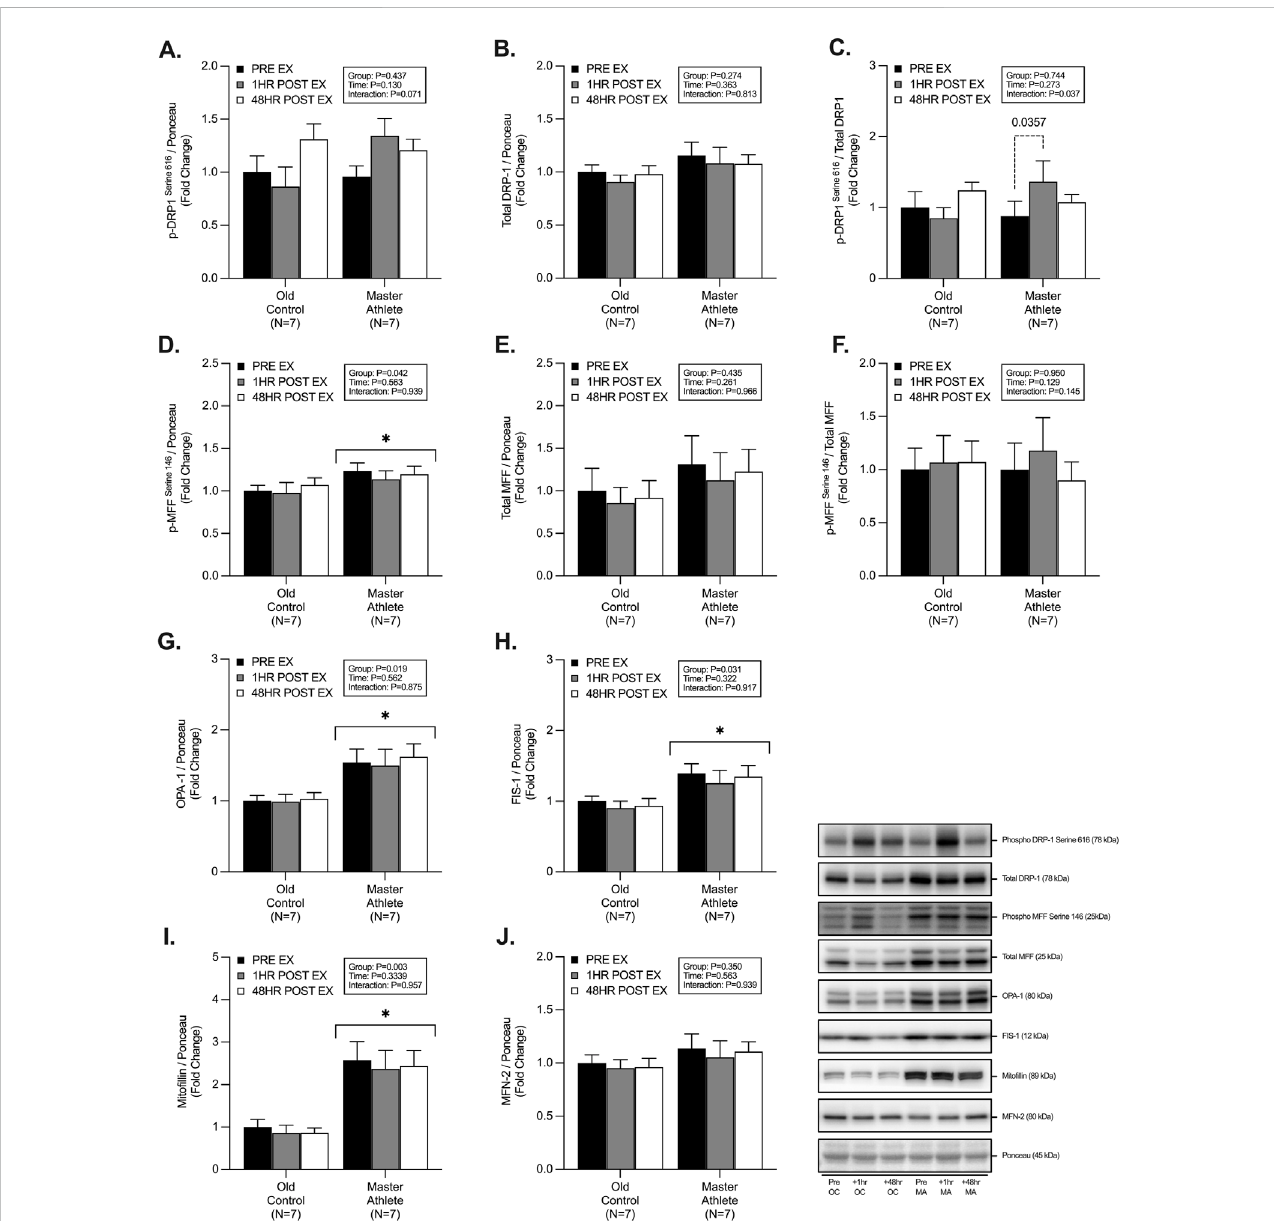
FIGURE 2 Master athletes display greater abundance of proteins involved in fi ssion and fusion dynamics compared with old controls. Intracellular mitochondrial signallingofphosphorylatedDRP1 Serine616 (A) totalDRP1 (B) phosphorylated:totalDRP1 (C) ,phosphorylatedMFF Serine146 (D) ,totalMFF (E) ,phosphorylated:total MFF (F) , OPA-1 (G) , FIS1 (H) , Mito fi lin (I) , MFN-2 (J) at rest (Black), 1 h post-resistance exercise (Grey), and 48 h post-resistance exercise (White) in older untrained controls (N = 7) and master athletes (N = 7). All proteins are expressed relative to the total protein stain (Ponceau S) and, where